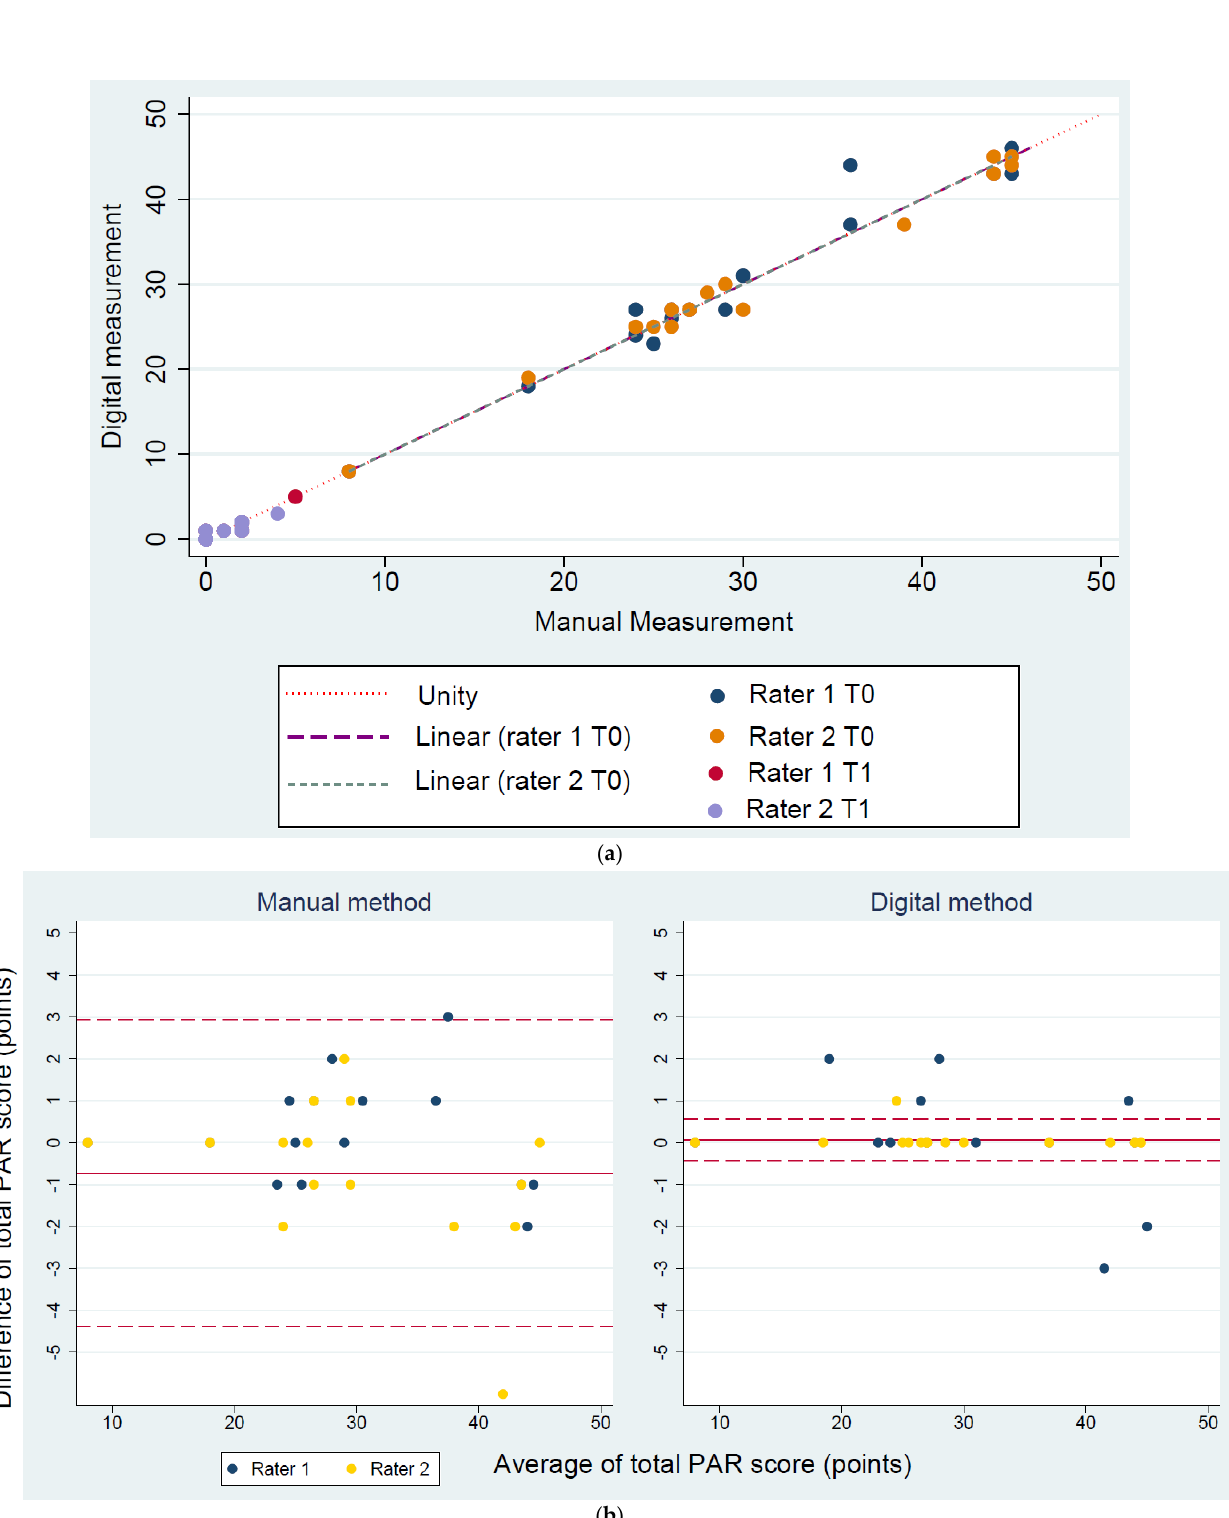
Figure 2. ( a ) Scatter plot of the total weighted PAR scores measured by both digital and manual methods and both raters, with a line of unity; ( b ) Bland-Altman plots: inter-rater agreement for the total PAR scores measured by the digital and manual PAR scoring methods at T0.